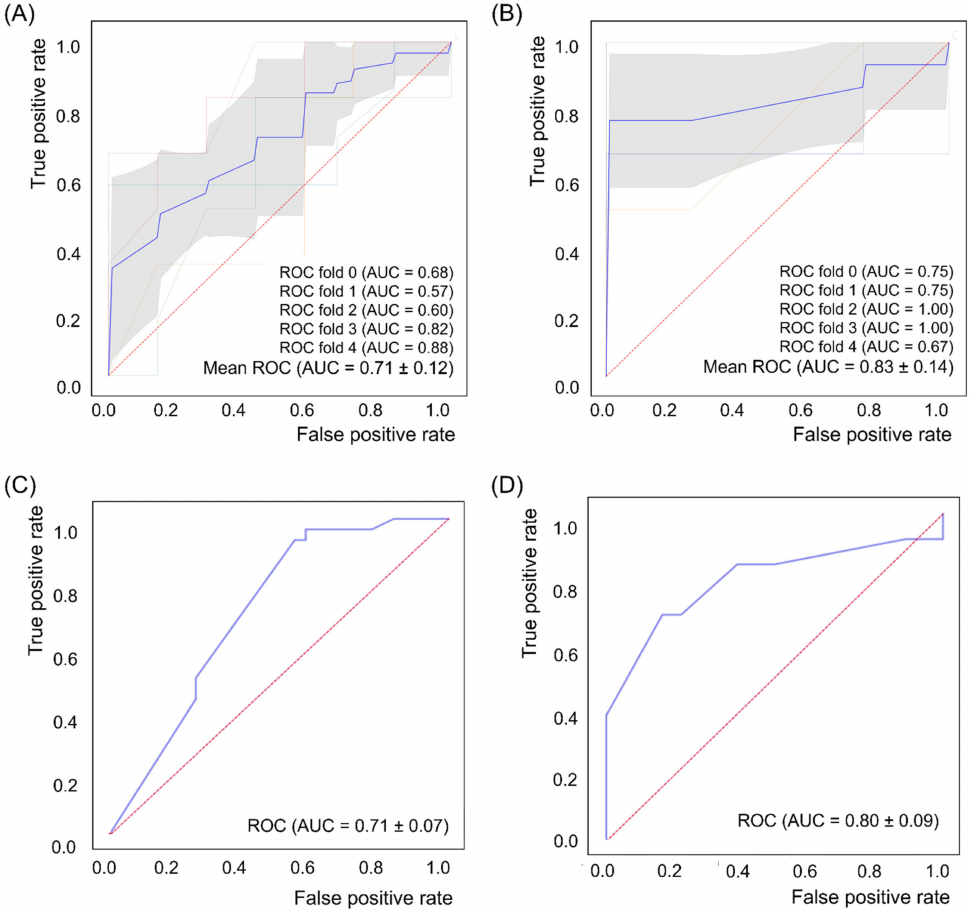
Figure 3. Receiver operating characteristic (ROC) curve for support vector machine with radial basis function kernel function algorithm with 10-fold cross-validation in the prediction of poststroke depres- sion (PSD) occurrence (control vs. PSD, ( A )), support vector machine linear algorithm with five-fold cross-validation in the prediction of PSD prognosis (improved vs. not improved, ( B )), and ROC curve for logistic regression analysis in the prediction of PSD occurrence ( C ) and PSD prognosis ( D